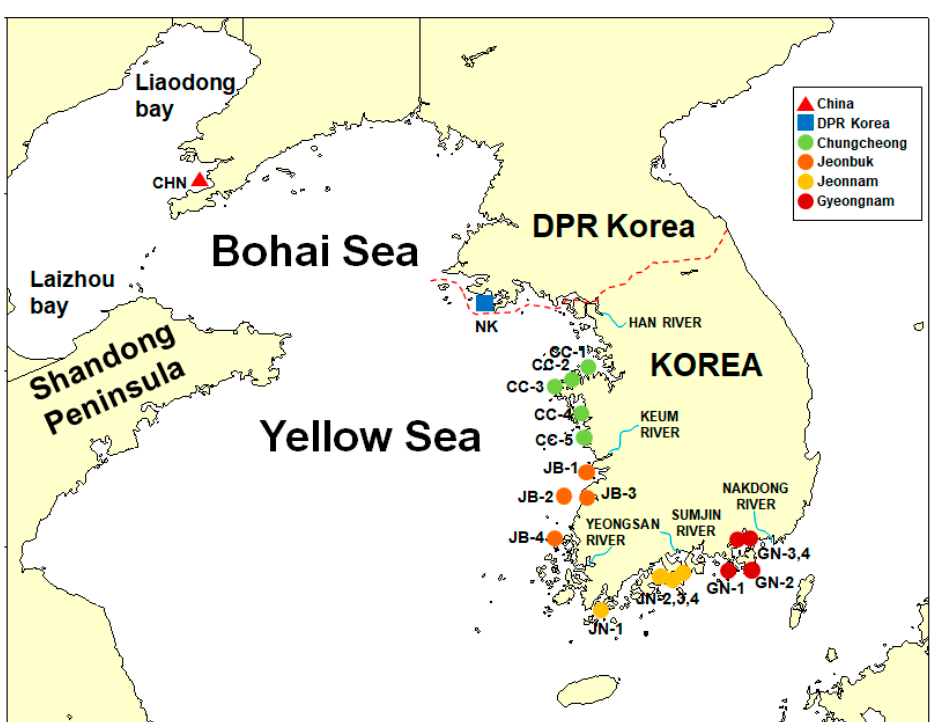
Figure 2. Regions of three countries from where samples of the clam Ruditapes philippinarum were collected. The triangle, square, and circles indicate the collection sites, that is, the sites of origin from China ( n = 15), the Democratic People’s Republic of Korea ( n = 16), and Korea ( n = 102), respectively. The collection sites in Korea are differentiated according to the provinces: Chungcheong (CC; n = 25), Jeonbuk (JB; n = 25), Jeonnam (JN; n = 26), and Gyeongnam (GN; n = 26).